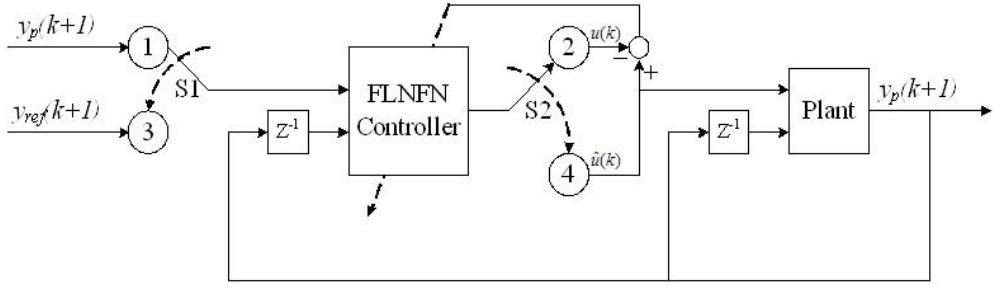
Figure 23. Schematic of the temperature control of the water bath system.